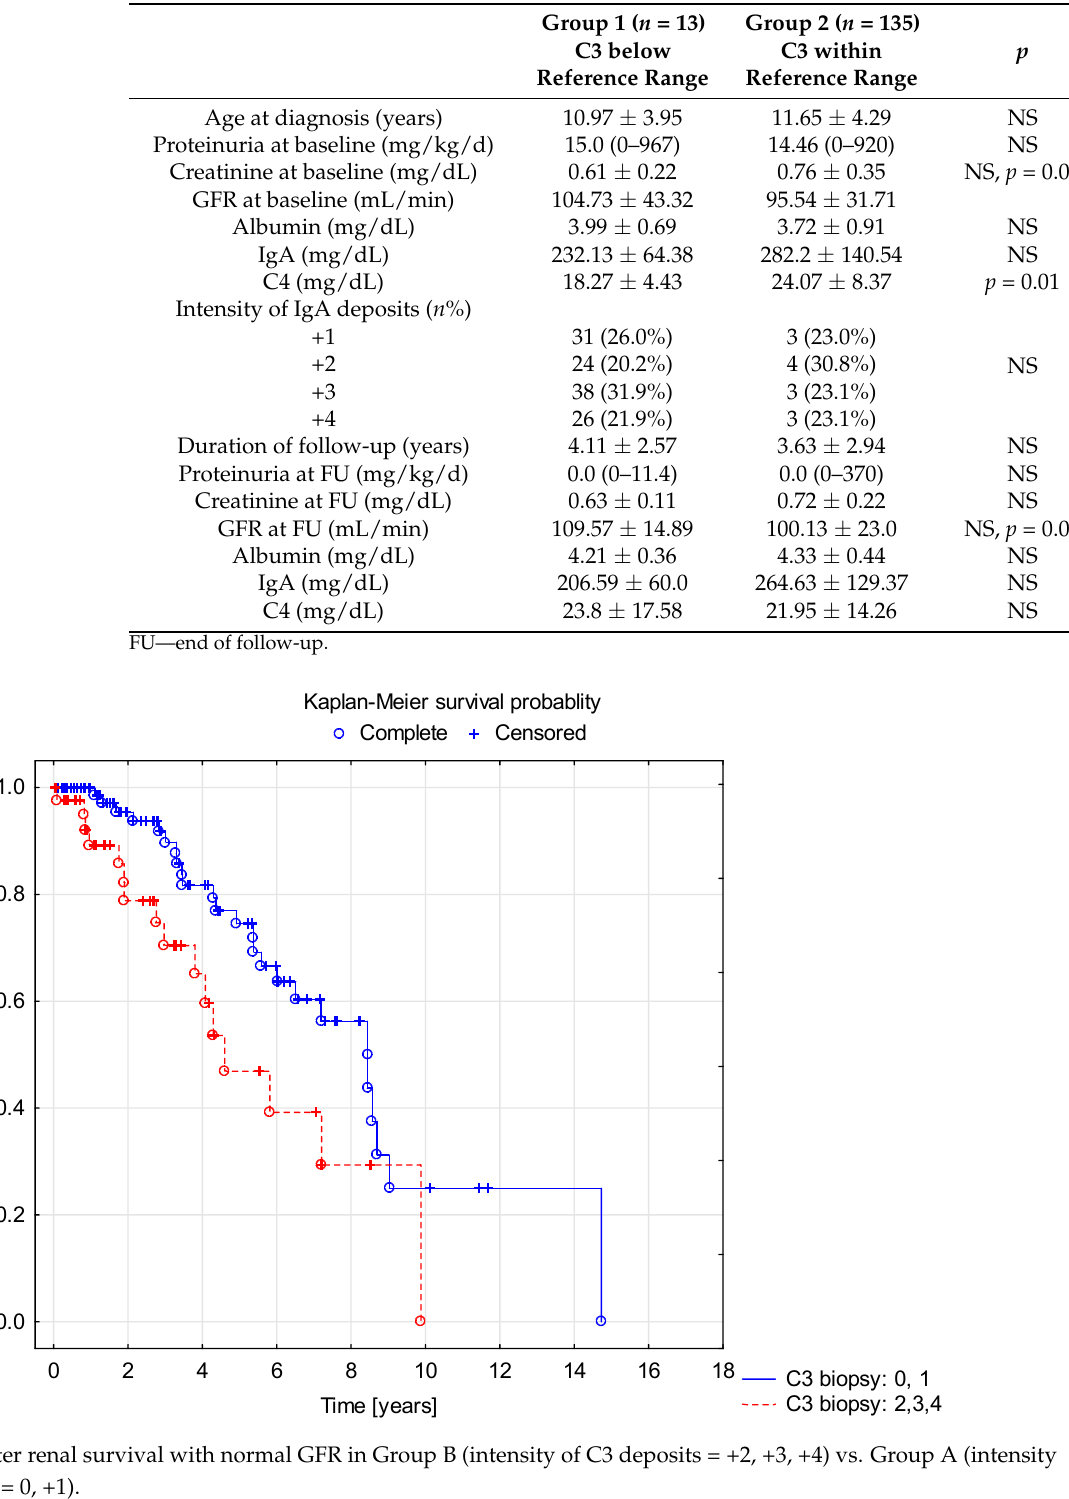
Table 4. Clinical characteristics of the patient groups based on serum C3 level.